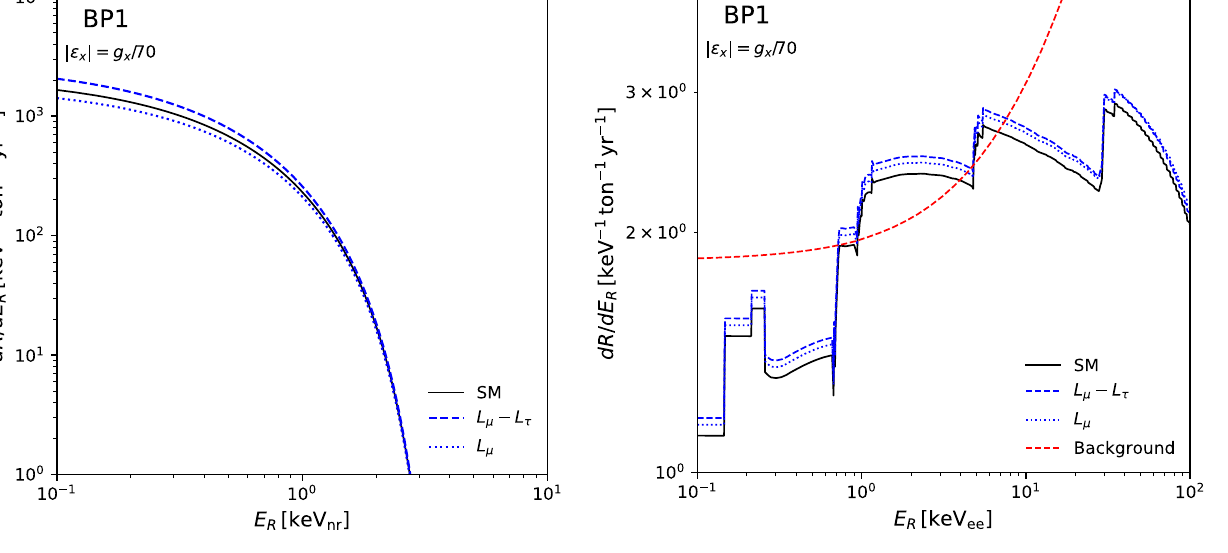
energy-independent scaling has been applied within the 0 . 25 − 30 keV energy window to account for the RRPA. We also show in this plot the relevant background by the red dashed line, based on the predictions for DARWIN given in Ref.